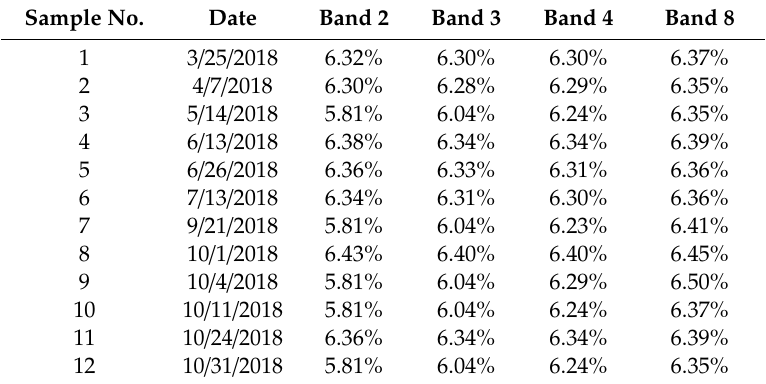
Table 12. The uncertainties of the degrees of equivalence for the 12 calibration samples in bands 2, 3, 4, and 8 of Sentinel-2B / MSI. Sample